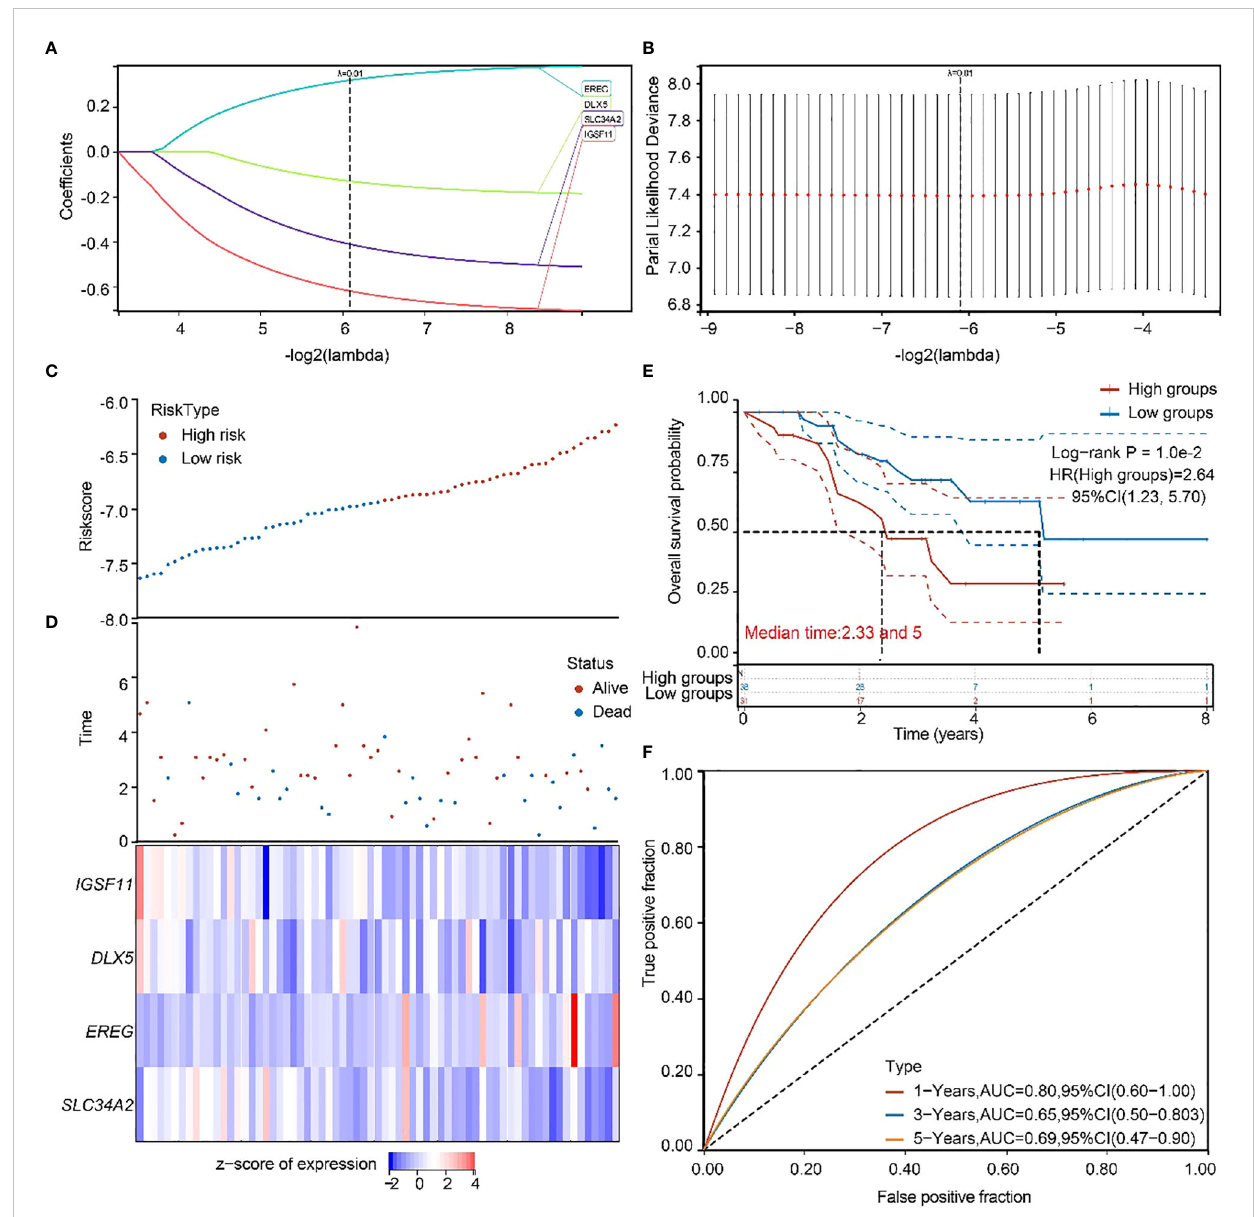
FIGURE 6 GEO independent dataset to validate the risk model. (A, B) Distribution of LASSO coef fi cients in the GSE73403 datasets, obtained by adjusting the parameters l .min = 0.0146. (C, D) Distribution of risk scores of the constructed models for the GSE73403 datasets. (E) KM survival curves for the high-and low-risk groups. (F) 1-year, 3-year, and 5-year ROC